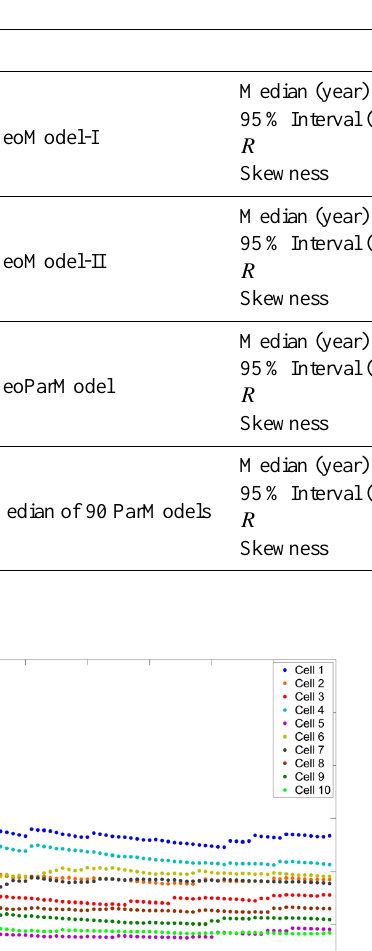
Table 3. Travel time based on backward particle tracking for four wells for GeoModel-I, GeoModel-II, GeoParModel, and median of Par- Models. R denotes the fraction of the 95% confidence interval to the one from GeoParModel. Location of the four wells is shown in Fig. 8.